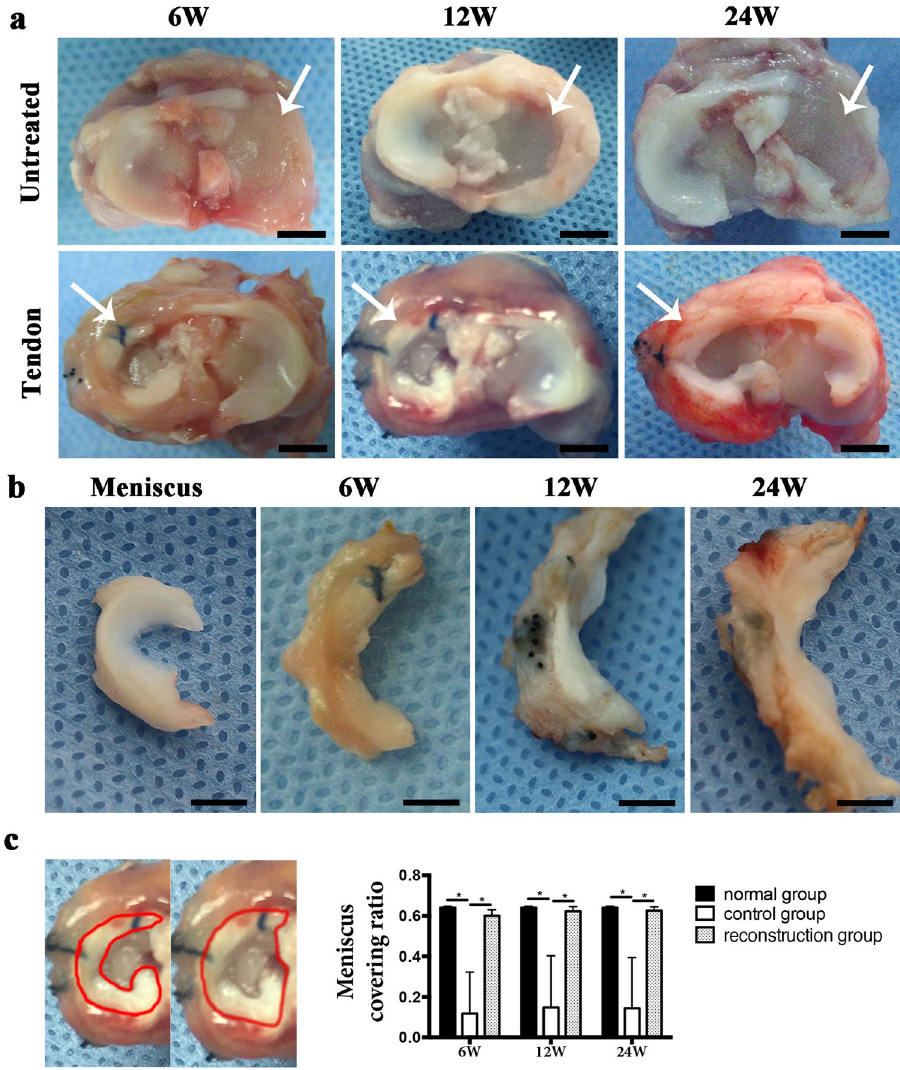
place in the red-white zone and white-white